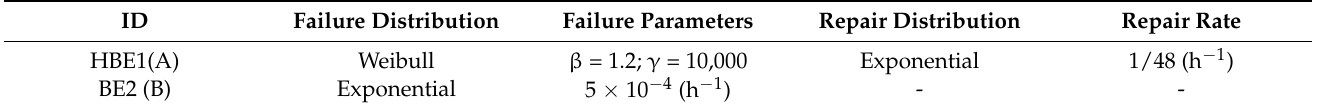
Table 7. Parameters of the system components.